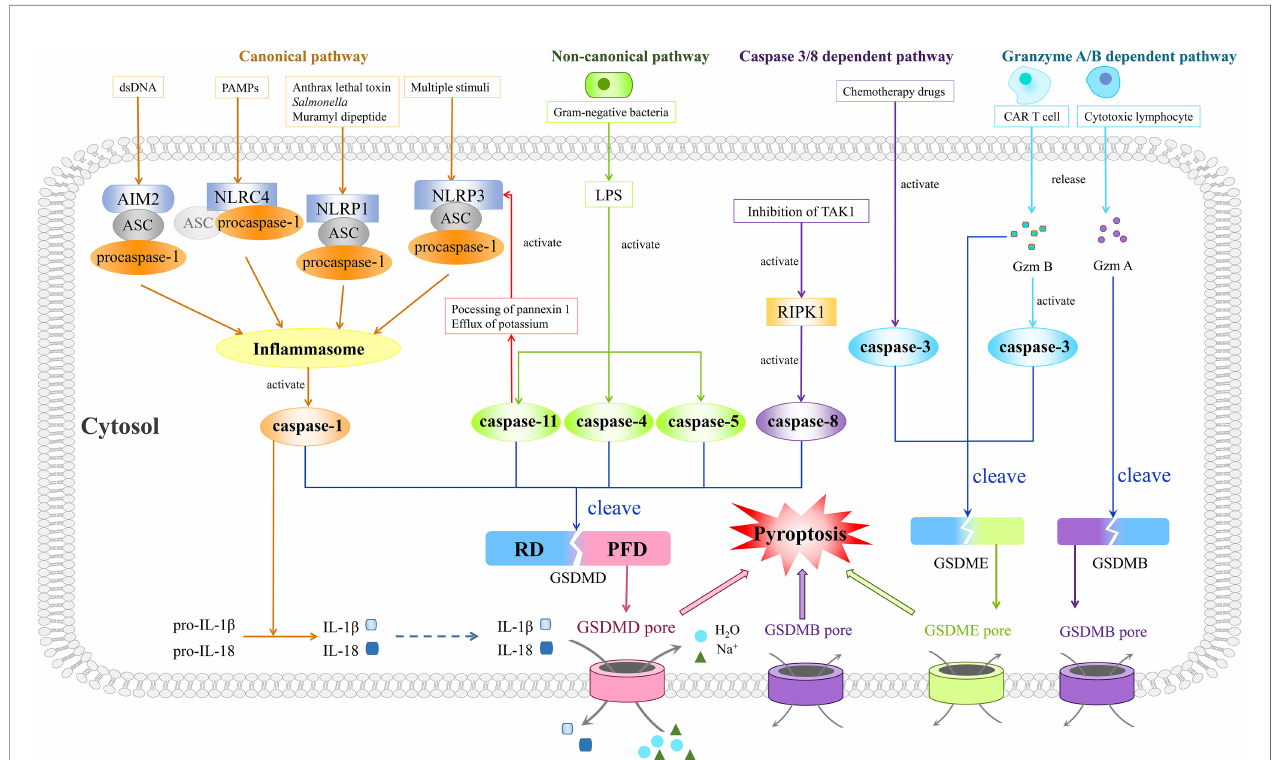
FIGURE 1 | Four prestigious pathways indicated in mechanisms of pyroptosis. Of note is that the canonical pathway is composed of in fl ammasomes, caspase-1, and GSDMD. Moreover, the in fl ammasome complex consists of PRRs (NLRP1, NLRP3, NLRC4, and AIM2), procaspase-1, and ASC, with the last one being dispensable in NLRC4 in fl ammasome. Different PRRs constitute corresponding types of in fl ammasomes and recognize different types of PAMPs or DAMPs. After recognition of PAMPs or DAMPs, the assembled in fl ammasomes activate caspase-1, thus cleaving GSDMD. The gasdermin pore formed by N-terminus of GSDMD results in pyroptosis characterized by outlet for IL-1 b and IL-18, in fl ux of sodium with water, swelling of cells, and fi nally osmotic lysis. In the non-canonical pathway, LPS derived from gram-negative bacteria could trigger pyroptosis through activating caspase-4, -5, and -11 to cleave GSDMD. Besides, the activated caspase-11 could also inspire the activation of the NLRP3 in fl ammasome. As for the caspase 3/8-dependent pathway, activated RIPK1 by inhibition of TAK1 helps caspase-8 to cut GSDMD and to mediate pyroptosis while the activated caspase-3 by chemotherapeutic drugs could split GSDME, leading to pyroptosis as well. In the granzyme A/B-dependent pathway, Gzm B released by CAR T cells could induce GSDME-modulated pyroptosis by both direct cleavage of GSDME and indirect cleavage of GSDME via activation of caspase-3, while cytotoxic lymphocyte-released Gzm A cleaves GSDMB to induce